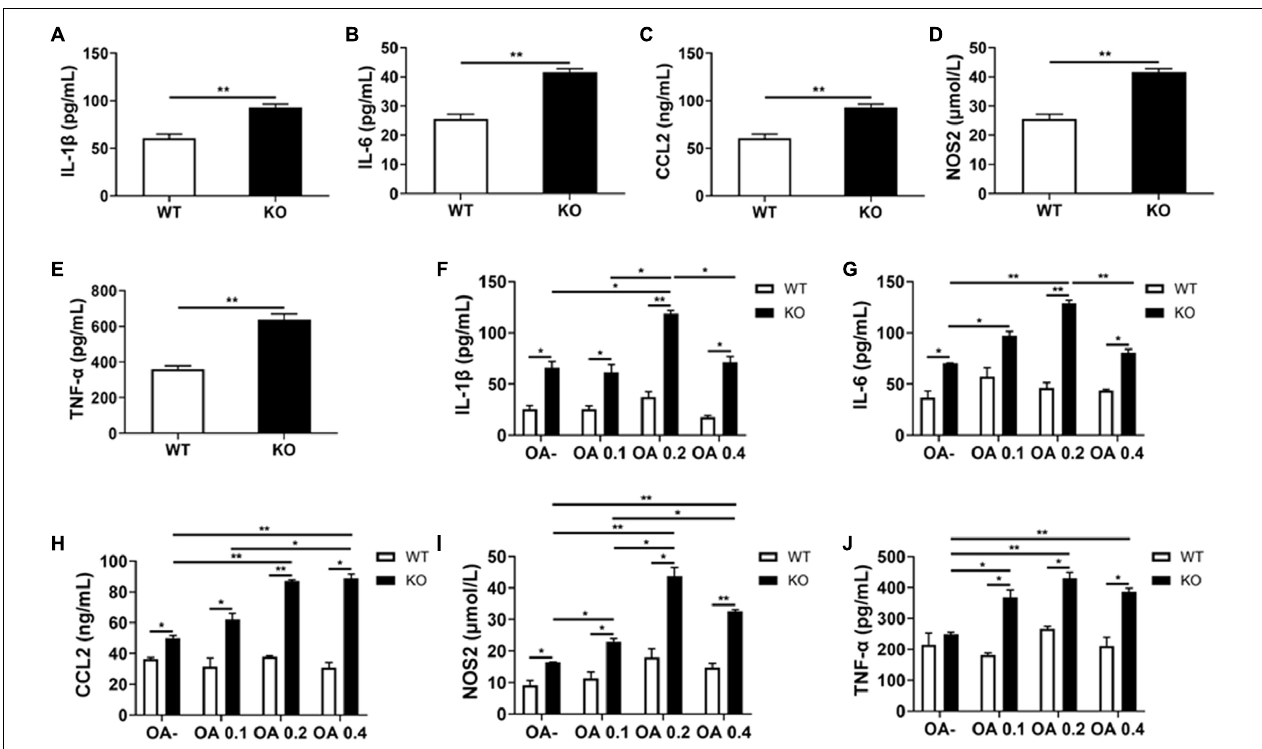
FIGURE 8 | LAMTOR1 MKO increases the levels of inflammatory factors. (A–E) Serum levels of inflammatory cytokines and of the CCL2 chemokine in HFD-fed mice. (F–J) Secretion of inflammatory cytokines and of the CCL2 chemokine in the context of Kupffer cells incubated with 0, 0.1, 0.2, and 0.4 mmol/L OA for 24 h. All of these inflammatory factors were measured via ELISA. The data expressed as the mean ± SEM, n = 4–6. * P < 0.05; ** P < 0.01. CCL2, C-C motif chemokine ligand 2; IL, Interleukin; KO, myeloid-specific knockout mice; NOS2, nitric oxide synthase 2; OA, oleic acid; TNF- α , tumor necrosis factor α ; WT,